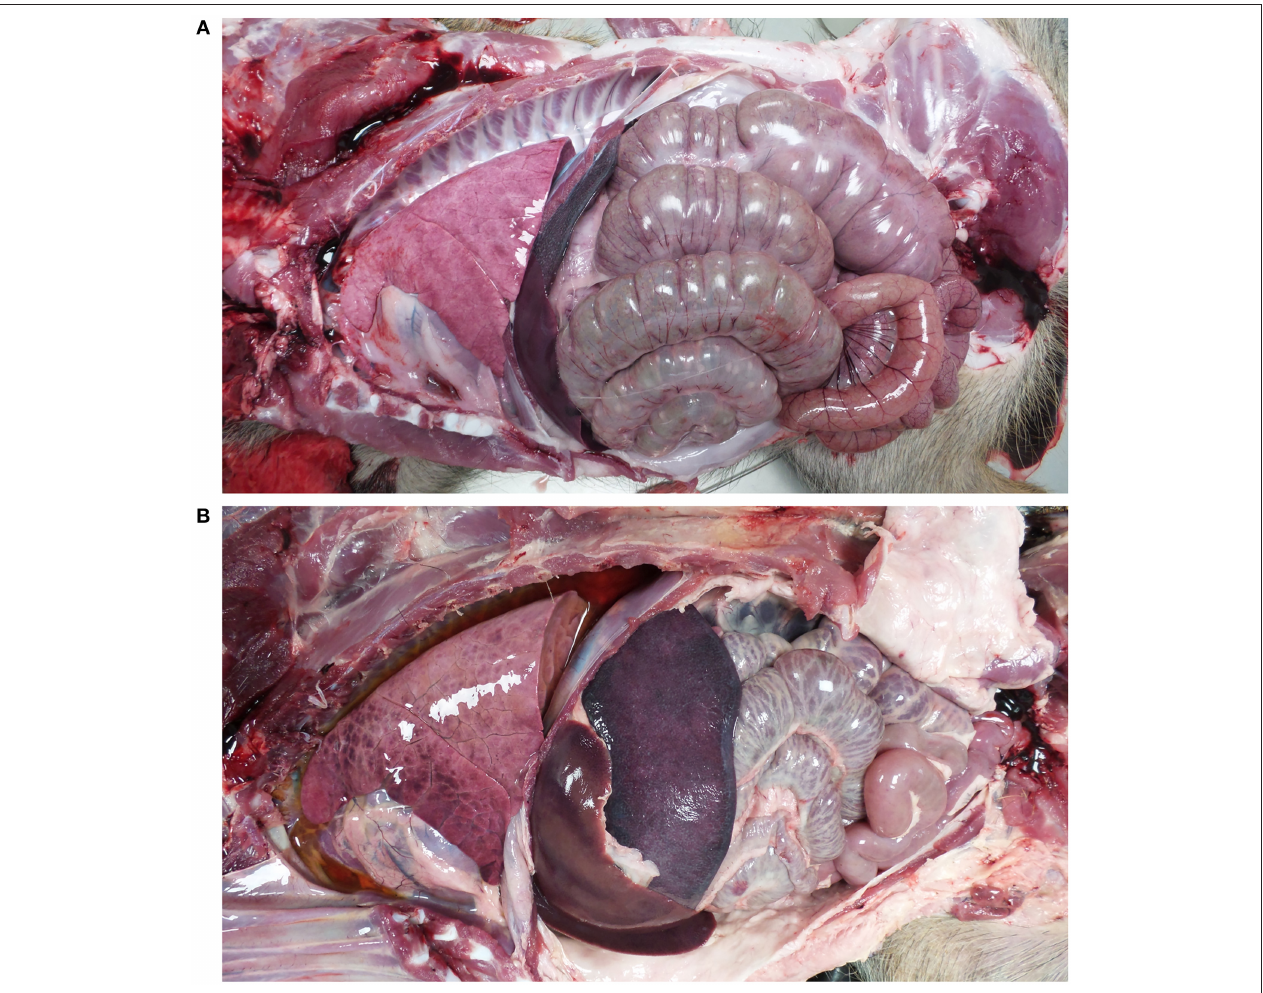
FIGURE 3 | Views of thoracic and abdominal cavities from (A) wild boar orally vaccinated with Lv17/WB/Rie1 and (B) intramuscularly challenged control with virulent ASFV Arm07. Hydrothorax, hepatomegaly, and splenomegaly are evident in (B)